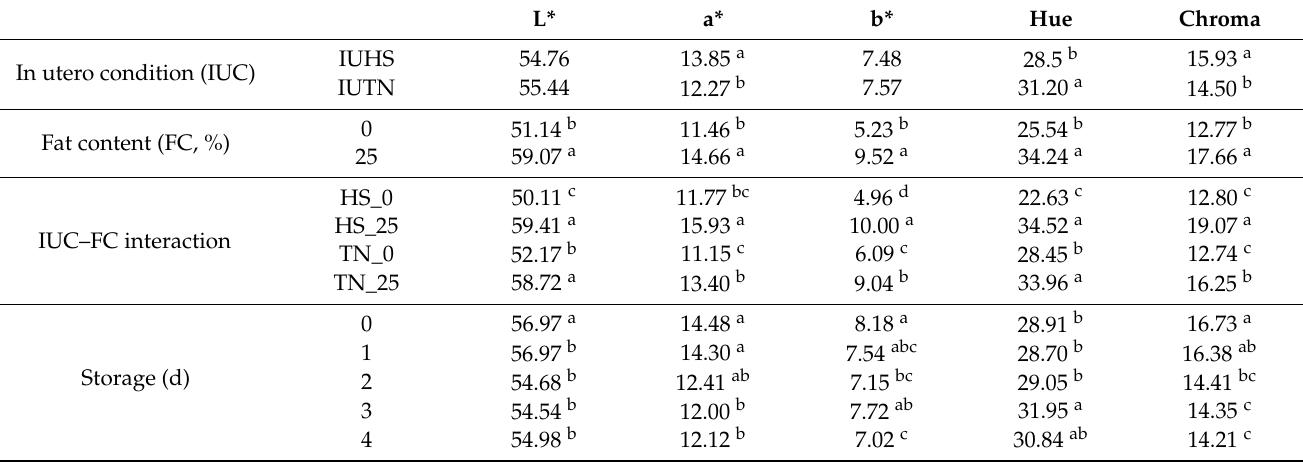
Table 6. Color attributes of pork